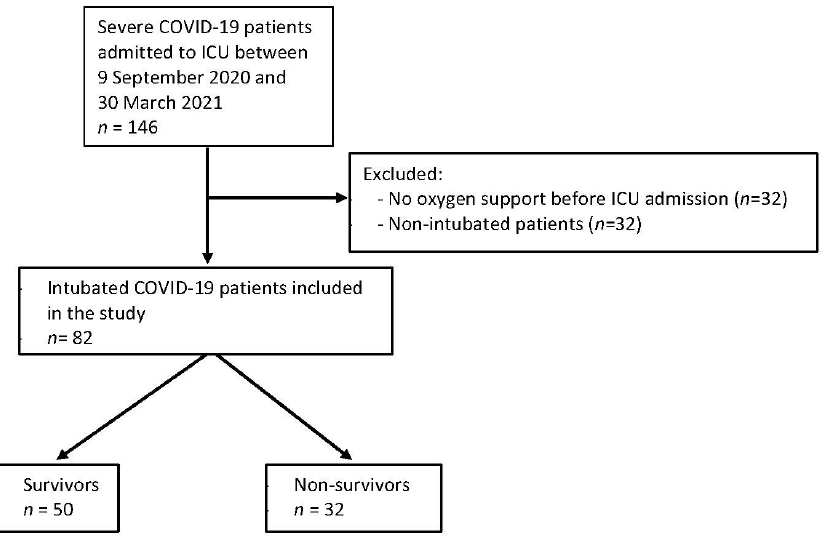
Figure 1. Flow chart study. Table 1. Patients ’ characteristics.